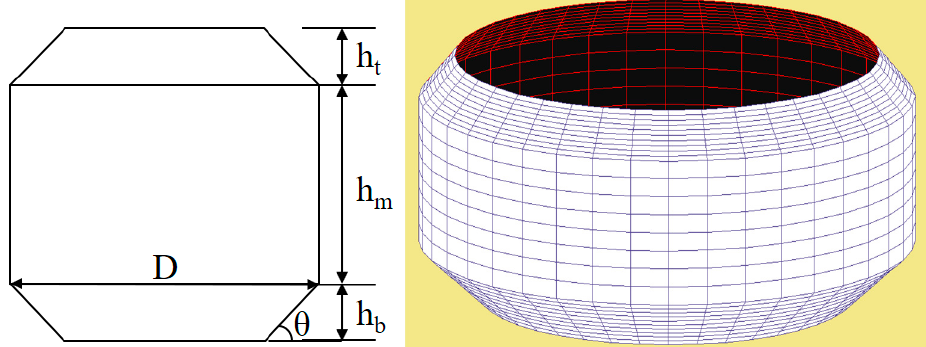
Figure 23. Inner tank wall with tapering at top and bottom.